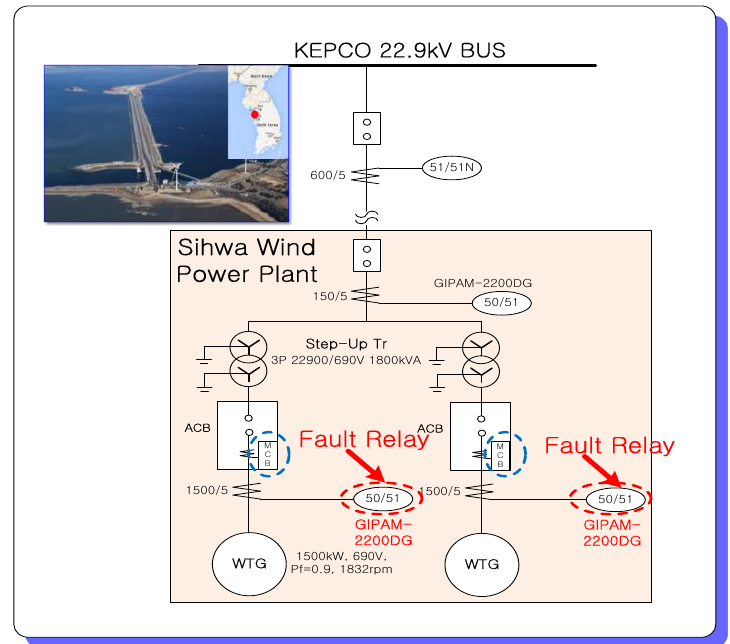
Figure 1. Single line diagram of Sihwa wind power system.